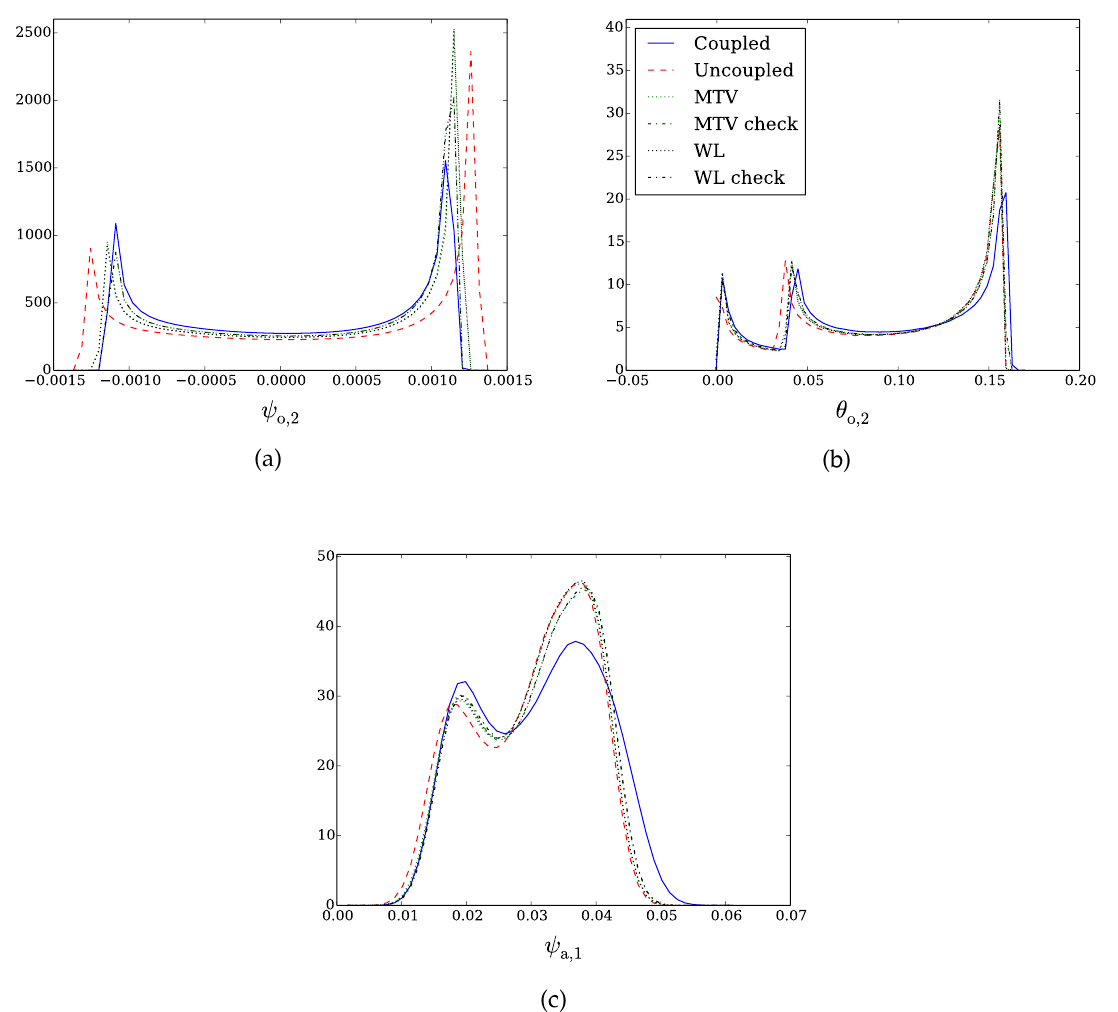
Figure 2. Probability density functions (PDFs) of the dominant variables of the system dynamics with the invariant manifold decomposition for the X and Y components. The densities of the full coupled system (13) and of the uncoupled system are depicted for the DV2017 parameter set, as well as the ones of the MTV and WL parameterizations and their verifications. The “check” label indicates that the correlations used for the parameterizations were analytical, while for the others they were obtained by numerical analysis.